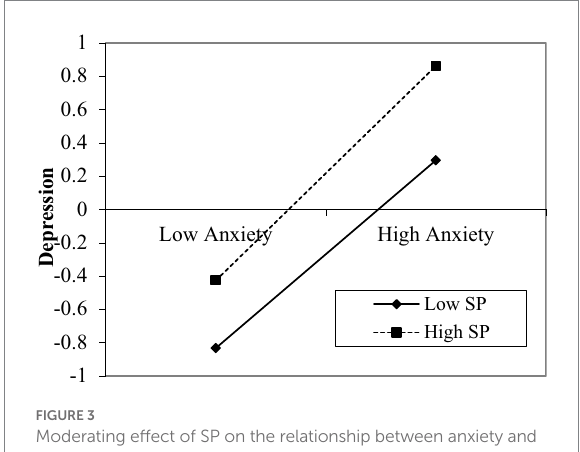
FIGURE 2 Moderating effect of PSS on the relationship between FC and anxiety. FC, fear of COVID-19; PSS, perceived social support.